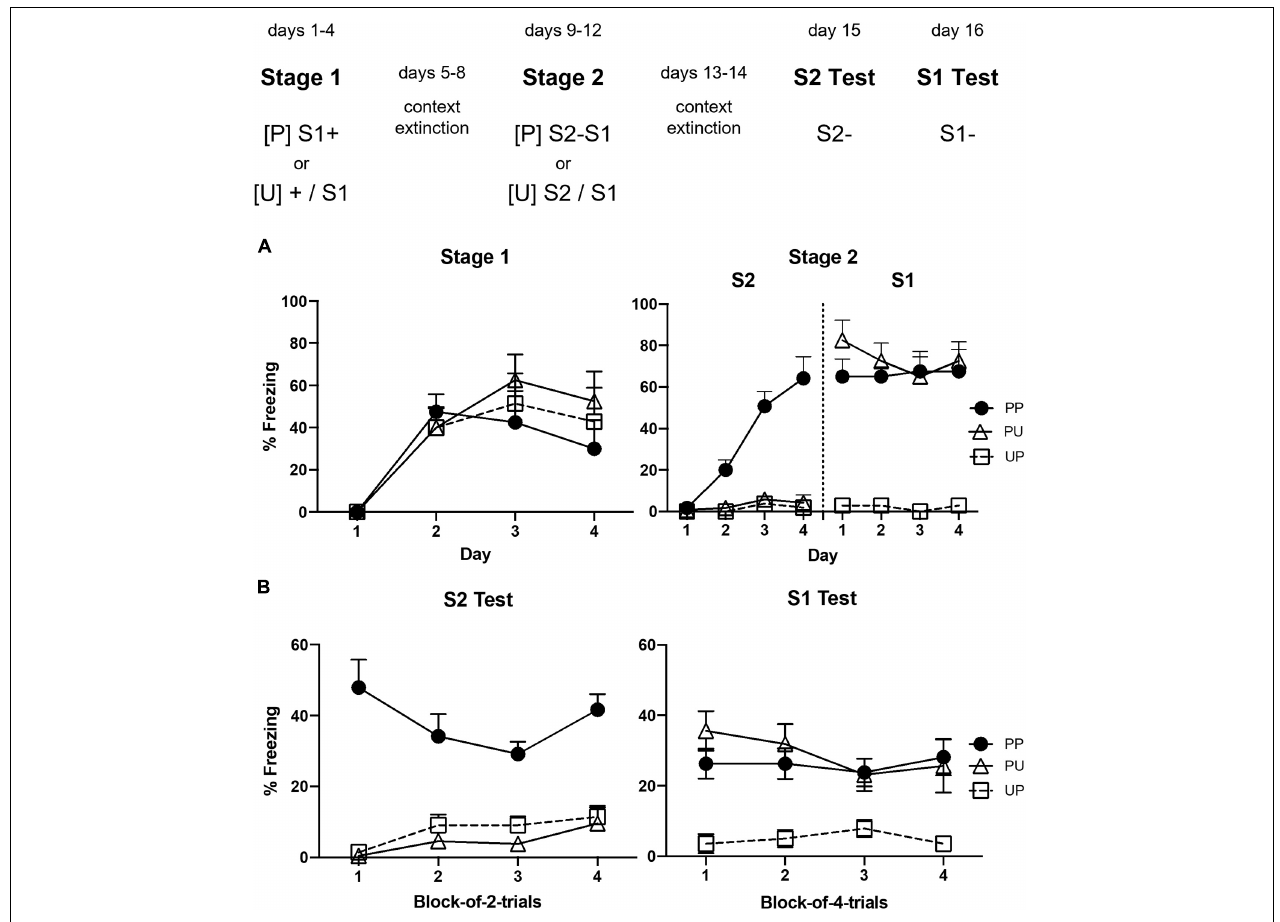
FIGURE 1 | Results of Experiment 1a showing that freezing to S2 is due to second-order conditioning. (A) Shows the mean (+ SEM) levels of freezing to S1 in stage 1 (left panel) and to S2 and the previously conditioned S1 in stage 2 (right panel). (B) Shows the mean (+ SEM) levels of freezing during the final drug-free tests across blocks of two S2 alone trials (left panel) and four S1 alone trials (right panel). The numbers of rats in each group were: Group PP, n = 8; Group PU, n = 8; and Group UP, n =